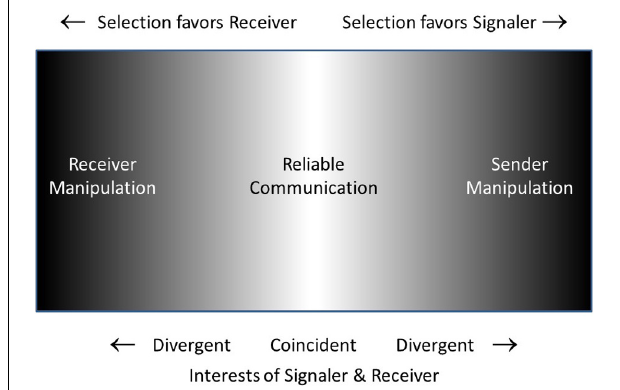
FIGURE 3 | Schematic suggesting the opposing pressures favoring signaler over receiver or vice-versa. Where interests of signaler and receiver are coincident or nearly so (light gray to white) reliable communication will occur. At the extremes of the space (darker), where interests of one or the other of the two parties predominates, signaling will be disfavored. In the intermediate (gray) region, one party may benefit more than the other, but signaling may still be ‘reliable